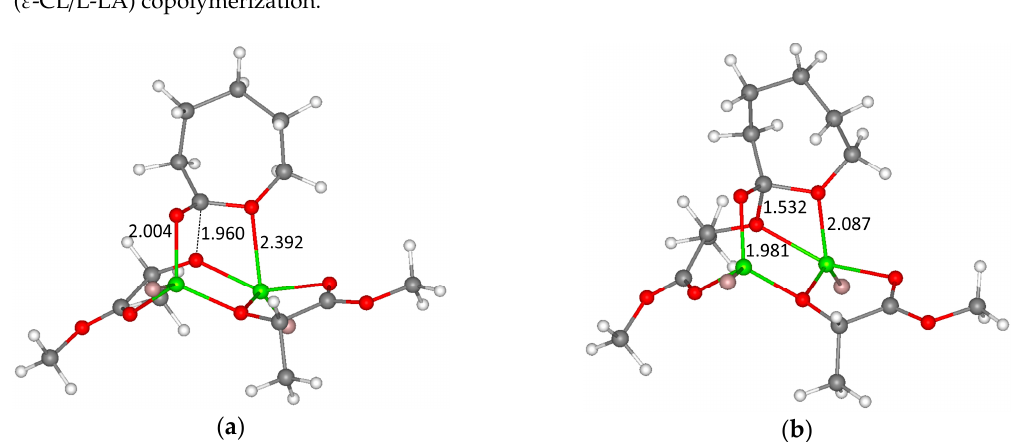
Figure 1. Calculated geometries of ( a ) TS-12_ lc ; ( b ) I-2_ lc . The 2,6-di- tert -butylphenoxy (DBP) fragments are omitted for clarity except the oxygen atom (marked by a rose). The distances O(lactate)–C( ε -CL carbonyl C atom) and O( ε -CL)–Mg are specified (Å).